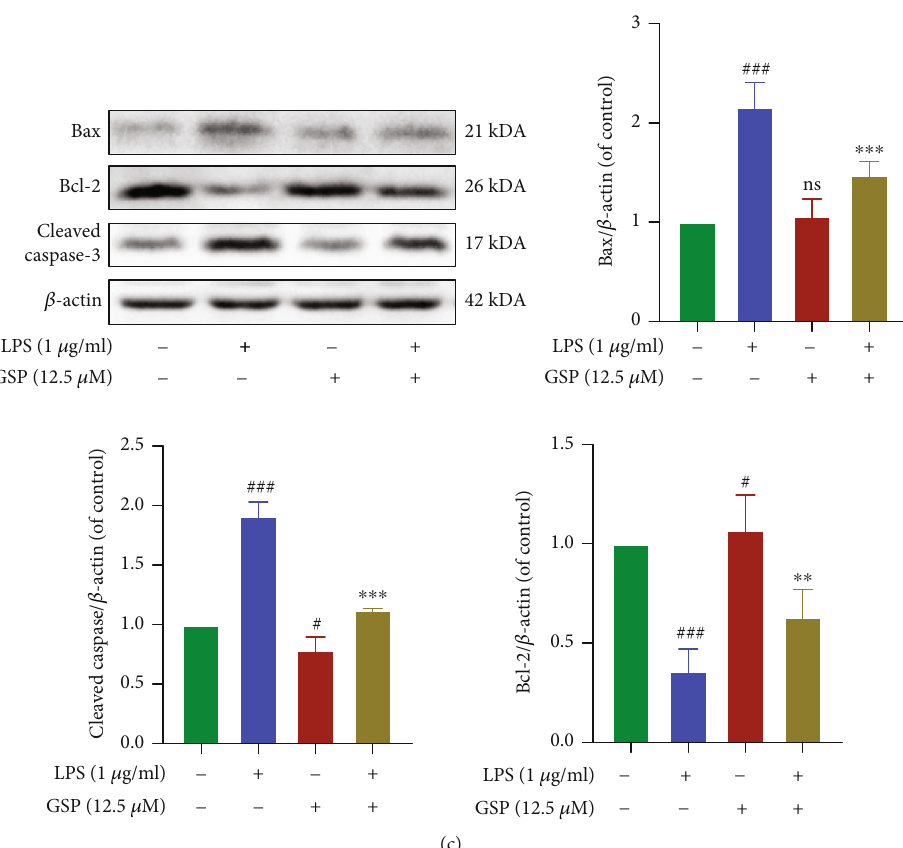
Figure 9: The antiapoptotic e ff ect of GSP. (a) BV-2 cell treatments and the coculture system. (b) Apoptosis rates were measured by fl ow cytometry. (c) Representative WB and quantitative data of apoptosis-related proteins in each group. # p < 0 : 05 or ### p < 0 : 001 vs. control group. ∗∗ p < 0 : 01 or ∗∗∗ p < 0 : 001 vs. LPS-treated